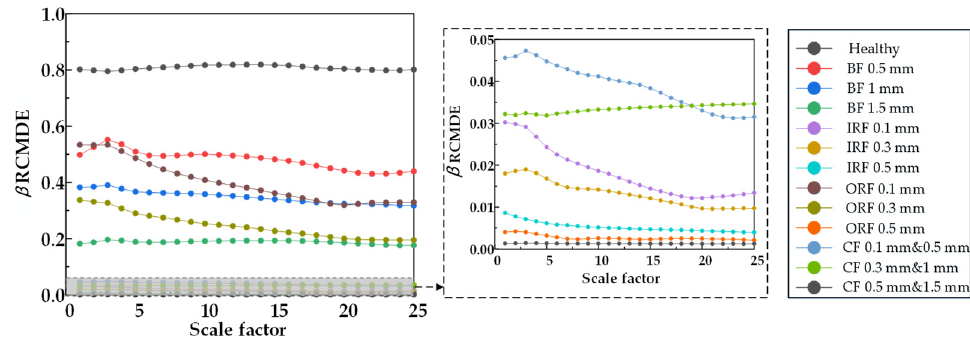
Figure 27. β RCMFE entropy values of 25 scale factors under different damage degrees.